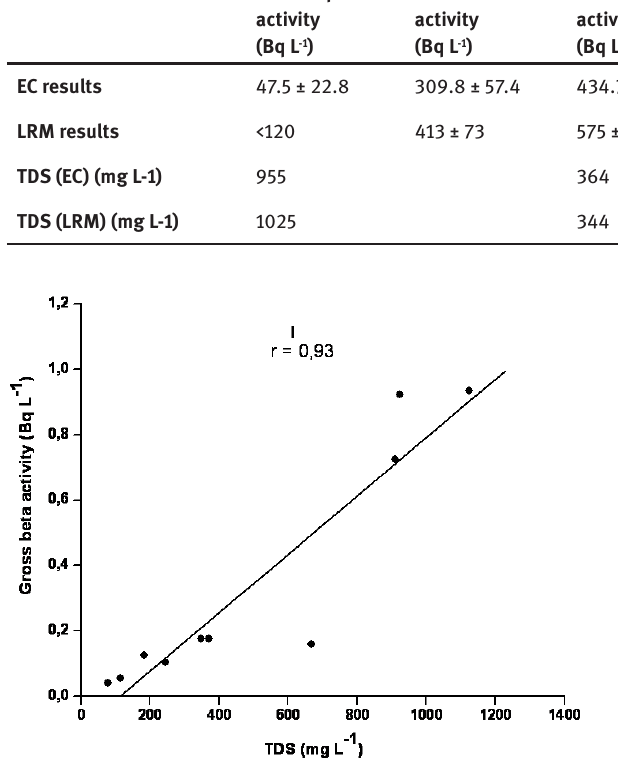
Figure 3 : Correlation between gross beta activity and the total dissolved solids using I method.